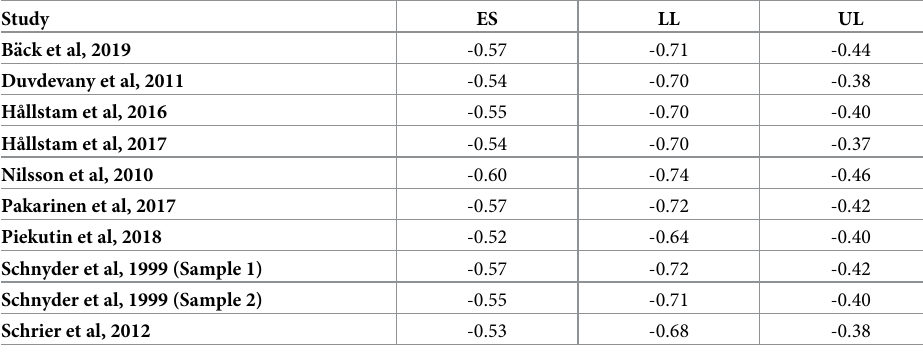
Table 3. Sensitivity analysis of the studies